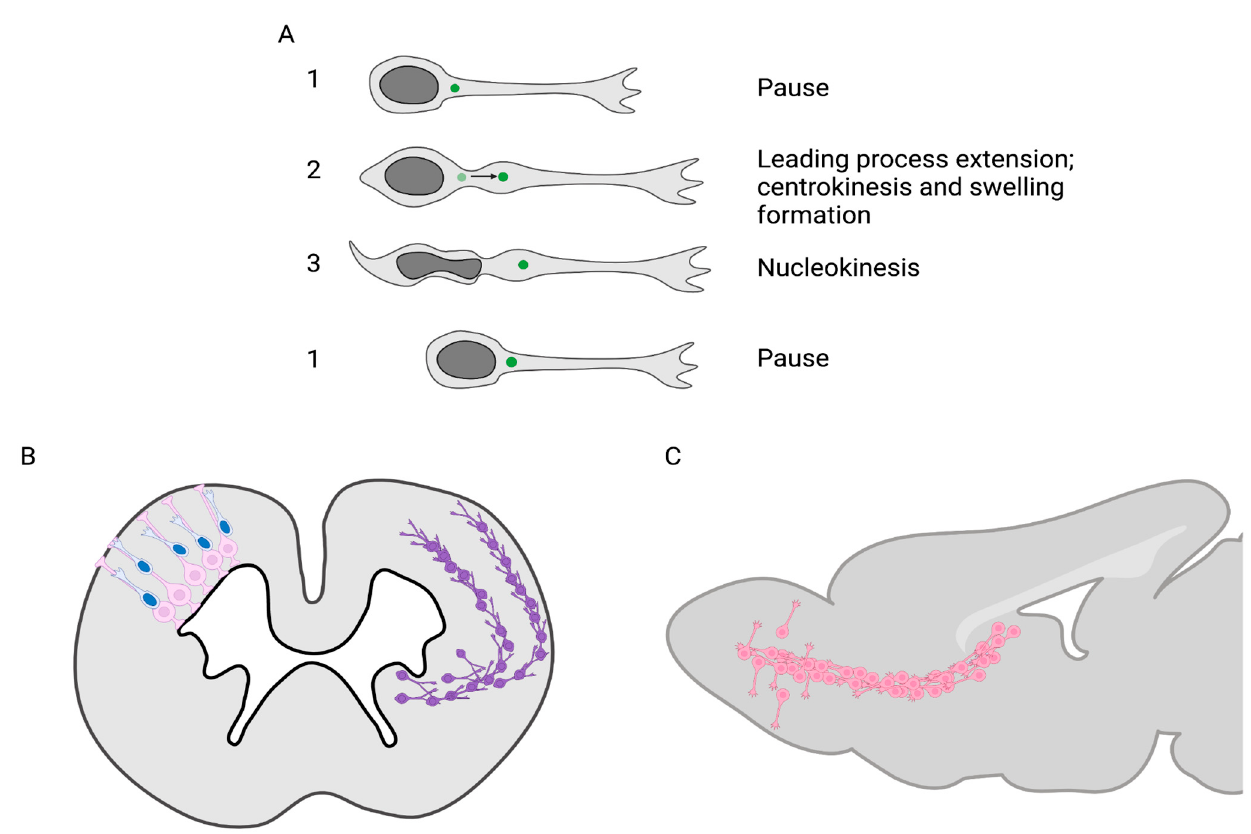
Figure 2 . Neuronal migration. ( A ) Neurons perform cyclic saltatory migration. 1. The neuron is in a pausing phase. 2. The centrosome migrates in a forming swelling in the proximal leading process (centrokinesis). 3. The nucleus moves forward (nucleokinesis). 1. The neuron pauses again, and the cycle can start again ( B ) In the embryonic cortex, two types of migration occur: the radial glial ‐ guided migration (shown in the left hemisphere) and the tangential migration (shown in the right hemisphere). Left: excitatory neurons are generated in the ventricular zone and migrate radially short distances along radial glia. Right: inhibitory interneurons are generated in the ganglionic eminences and migrate long distances tangentially in two different streams before re ‐ orienting radially to the cortical plate. ( C ) In the postnatal and adult Rostral Migratory Stream, neuroblasts are generated in the ventricular/subventricular zone and migrate tangentially to the olfactory bulb, where they reorient and migrate radially to integrate the pre ‐ existing network.